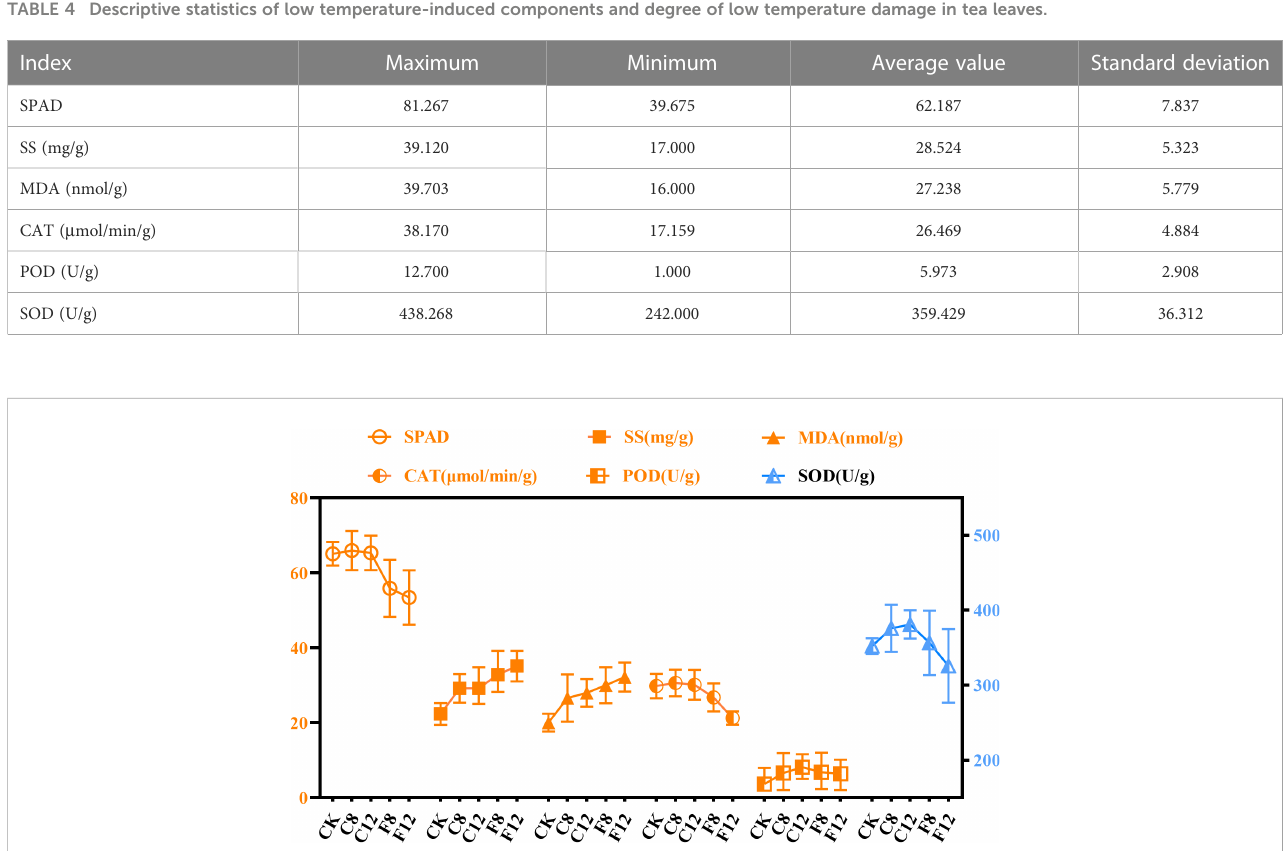
TABLE 4 Descriptive statistics of low temperature-induced components and degree of low temperature damage in tea leaves.